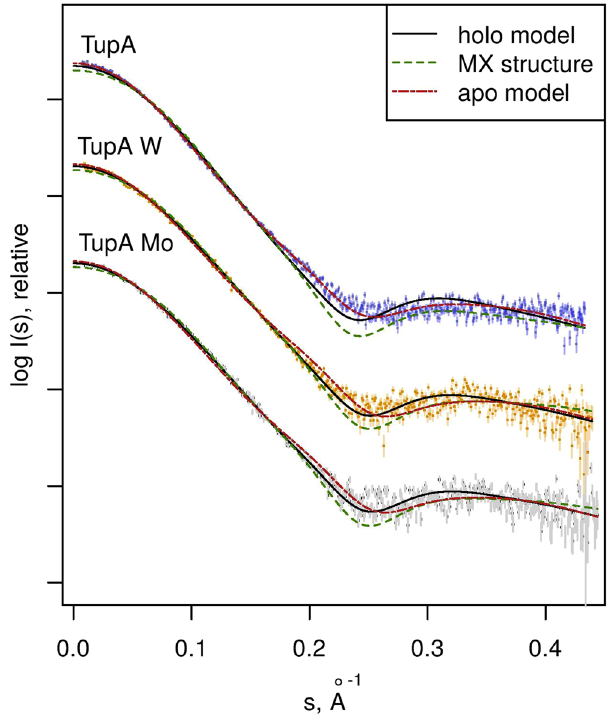
Figure 4. SAXS scattering data (points) for the three experimental conditions, TupA in the absence (TupA) and presence of tungstate (TupA W) or molybdate (TupA Mo). Each dataset has been scaled for display purposes. For each experimental curve, CRYSOL fits are displayed for the crystallographic structure reported in this work (MX) and the holo- and apo-form models generated thereof. The best fit for TupA is the apo-form model ( χ 2 = 1.0), while the best fit for both TupA W and TupA Mo is the holo-form model ( χ 2 = 0.9).